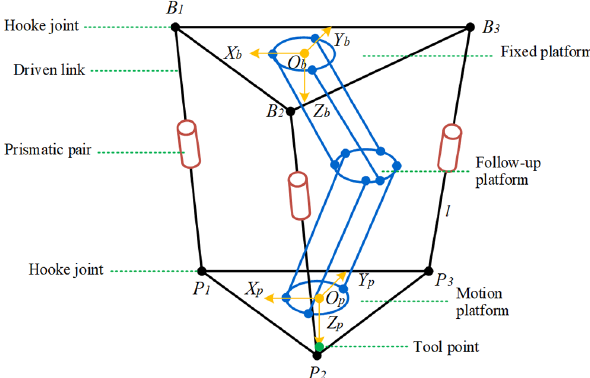
Figure 1. 3-TPT Parallel Mechanism Schematic